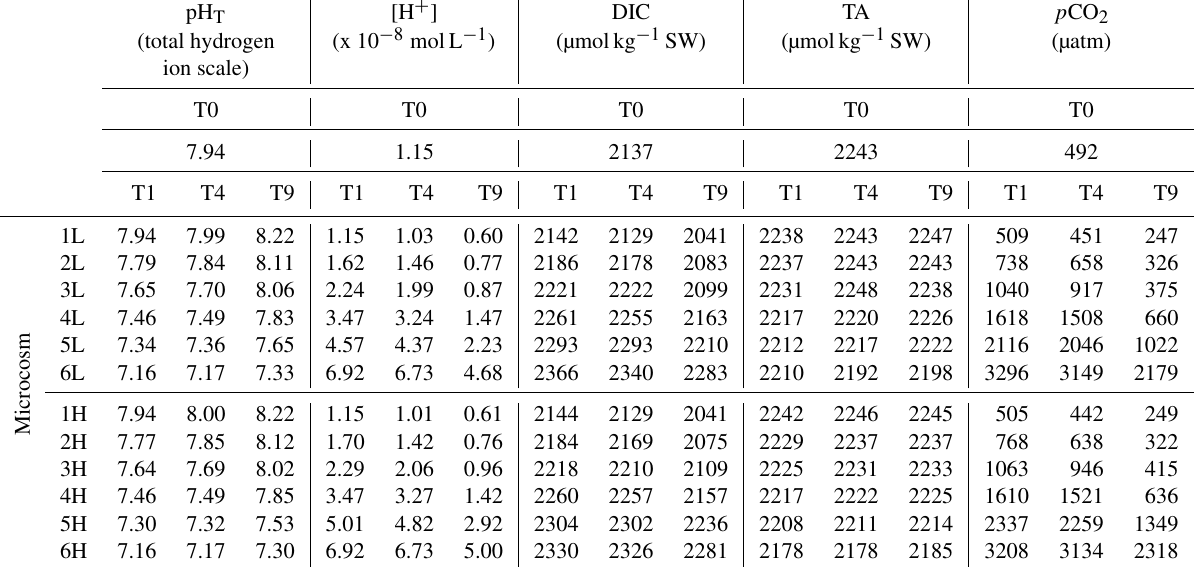
Table 1. Values of pH T (total hydrogen ion scale), the associated proton concentration [H + ], dissolved inorganic carbon (DIC), total alkalinity (TA), and p CO 2 in the microcosms under low light (LL) and high light (HL) treatments on days T0, T1, T4, and T9. Values of p CO 2 were calculated using CO 2 SYS software; values of proton concentrations were calculated after the pH T measurements. 1L and 1H are the control